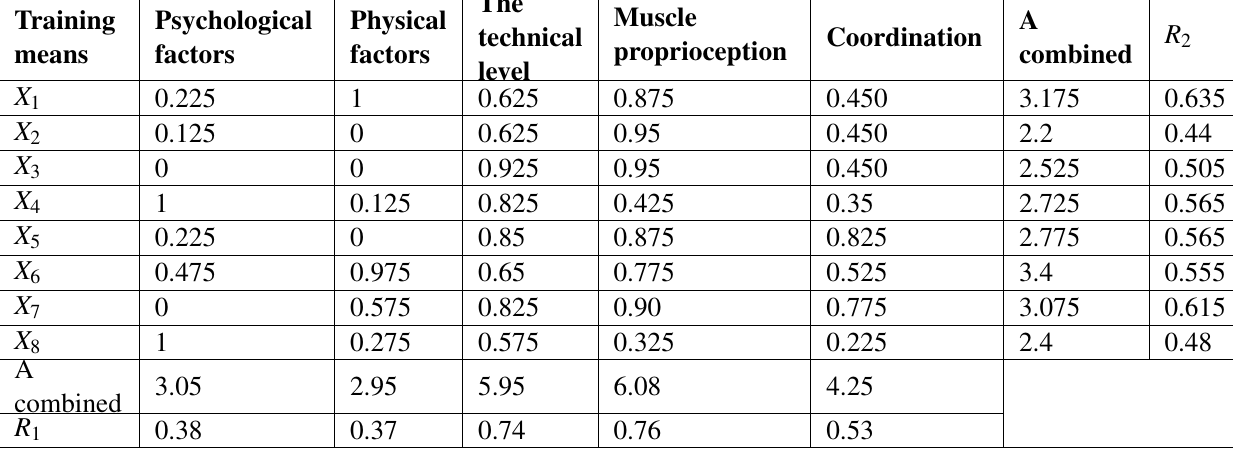
Table 1 Correlation matrix of various training methods and influencing factors of free throw